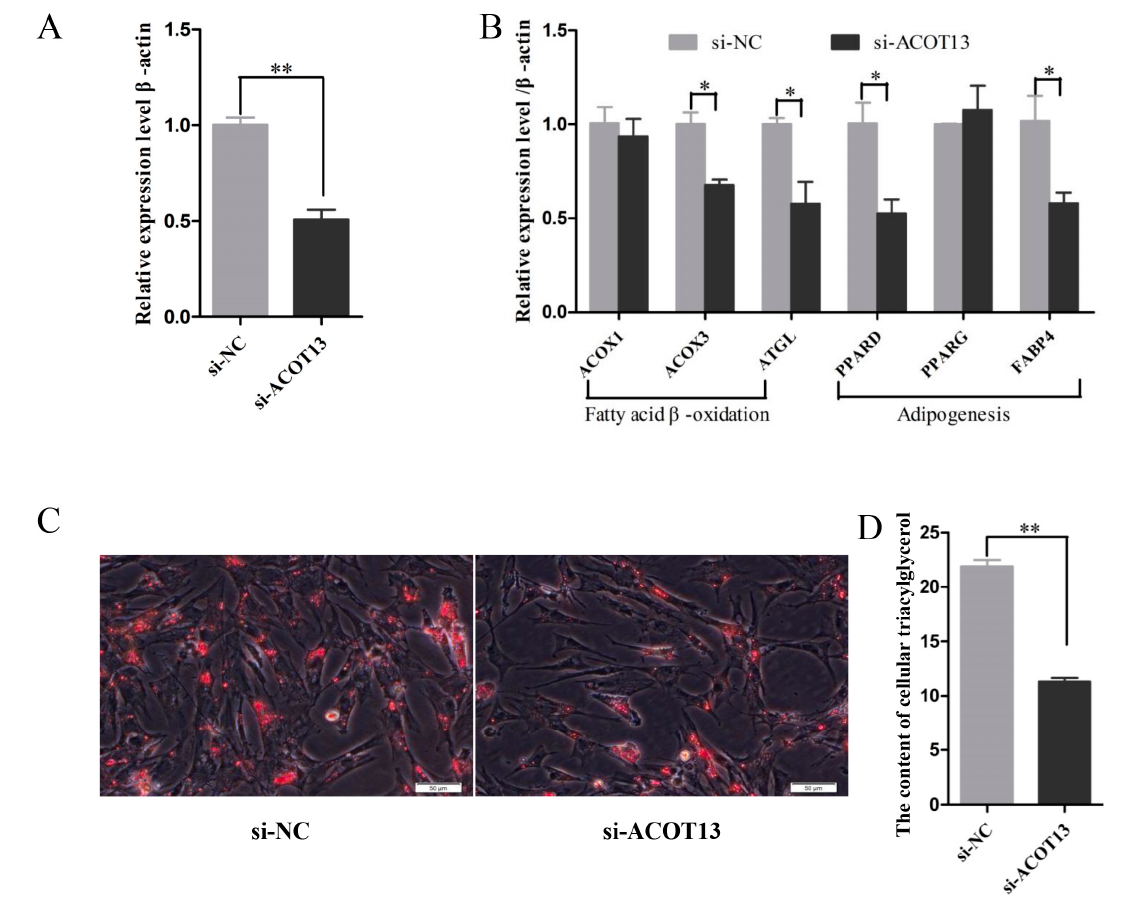
Figure 7. Knockdown of ACOT13 inhibited adipocyte di ff erentiation in intramuscular adipocytes. ( A ) ACOT13 levels were reduced by the si-ACOT13. ( B ) Levels of ACOX3 , ATGL , PPARD, and FABP4 mRNAs decreased after transfection with si-ACOT13. ( C ) si-ACOT13 decreased the lipid droplet formation in intramuscular adipocytes by Oil Red O staining. ( D ) After transfection of si-ACOT13, triacylglycerol synthesis was decreased. * p < 0.05; ** p < 0.01.